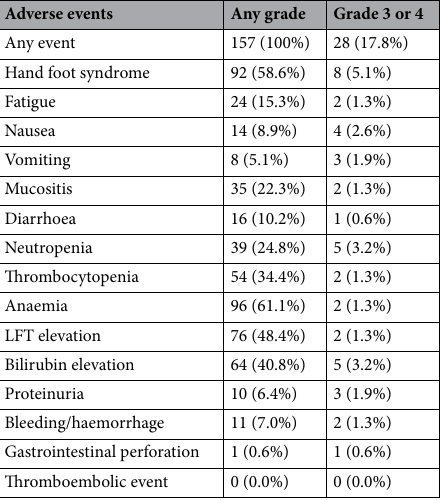
Table 4. Adverse event after bevacizumab/capecitabine